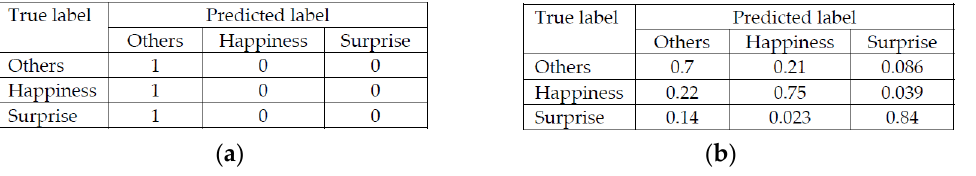
Figure 11. Confusion matrices of DS‑3DCNN without domain adaptation: ( a ) SAMM dataset and ( b ) SMIC